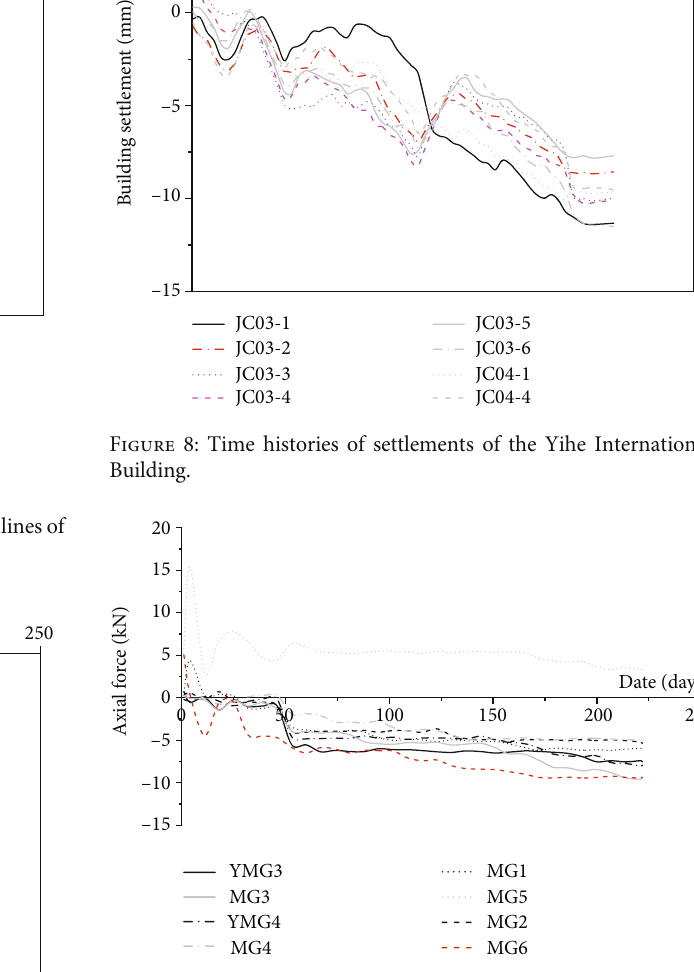
Figure 9: Time histories of axial forces in ground anchors.